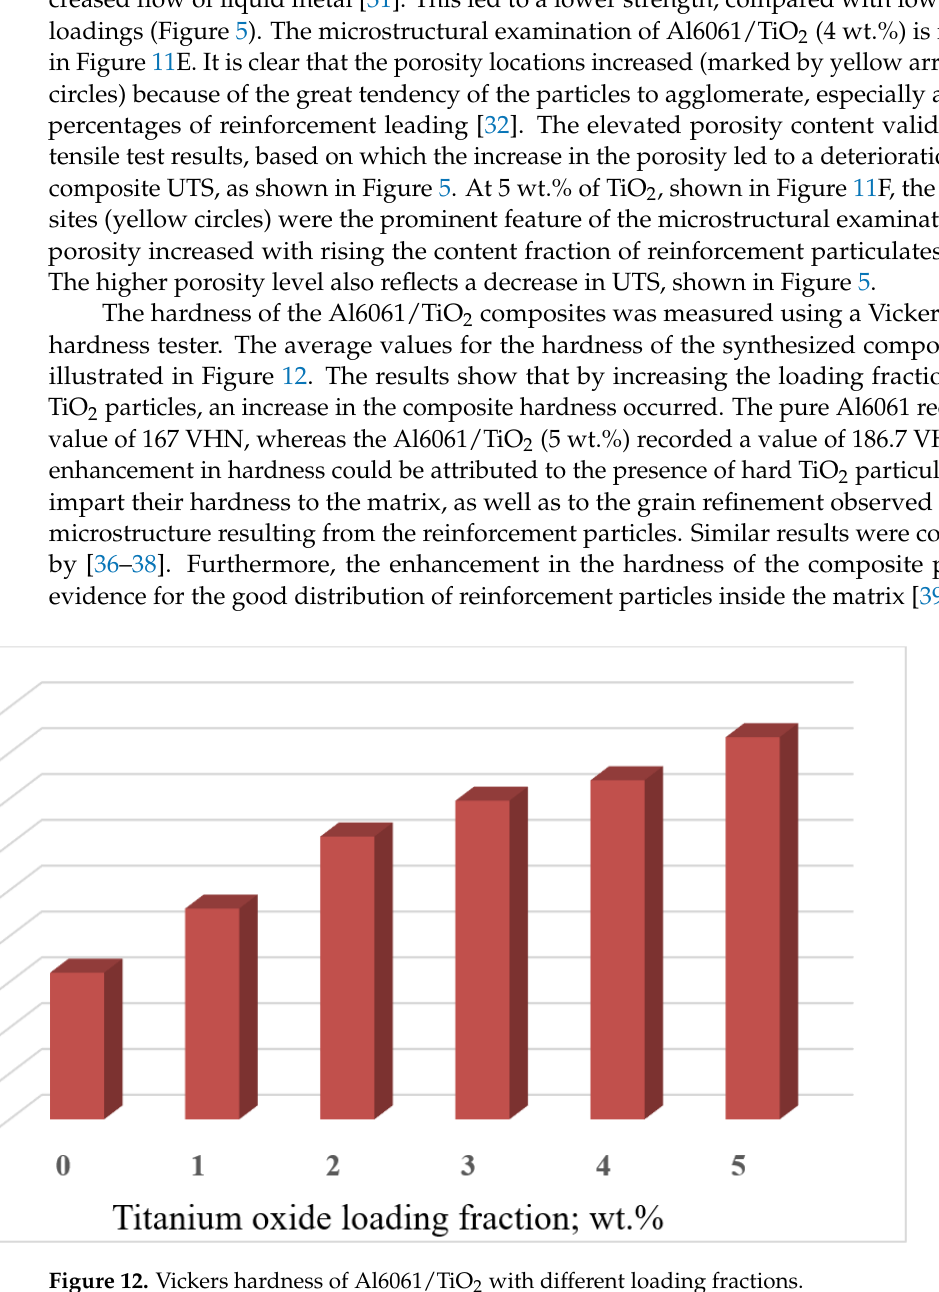
Figure 12. Vickers hardness of Al6061/TiO 2 with different loading fractions.